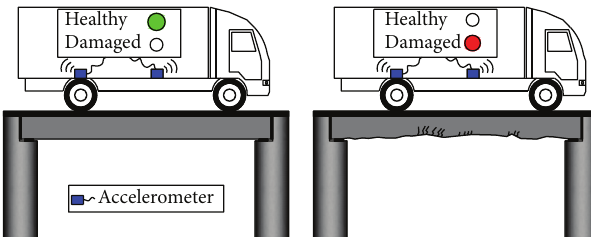
Figure 1: Indirect bridge health monitoring concept.